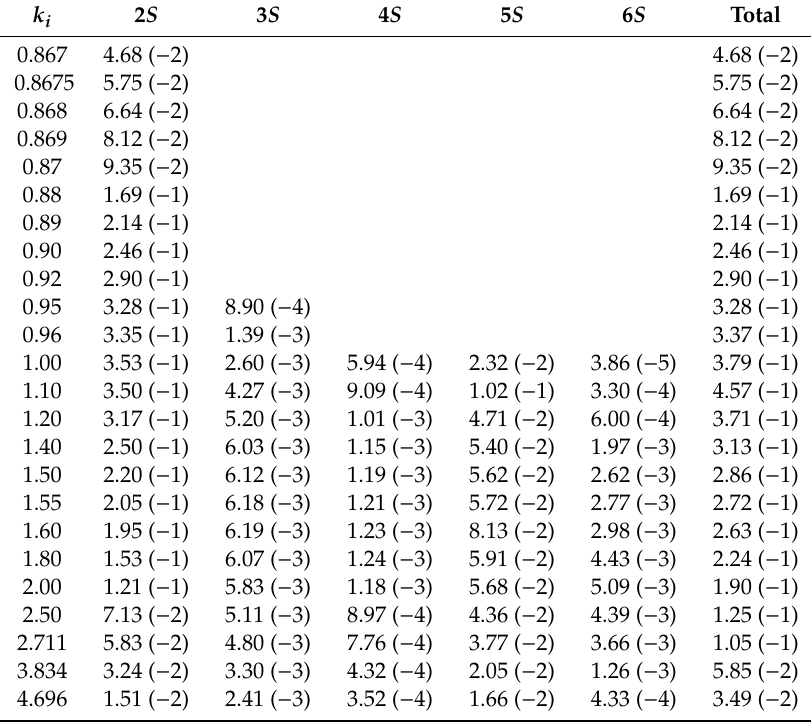
Table 1. Excitation cross sections of nS states, n = 1 to 6, of atomic hydrogen using the variational polarized orbital method with l max = 8.